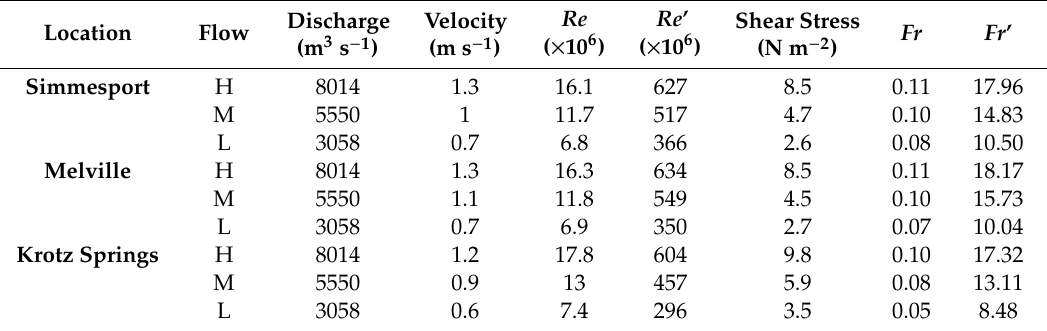
Table 3. Global and local Reynolds Number ( Re , Re ’), bed shear stress, and global and local Froude Number ( Fr , Fr ’) under di ff erent flow conditions at Simmesport (RK 15), Melville (RK 29), and Krotz Springs (RK 53). Three flow conditions, i.e., high (H), medium (M), and low (L) flow, were derived based on the long-term discharge records at